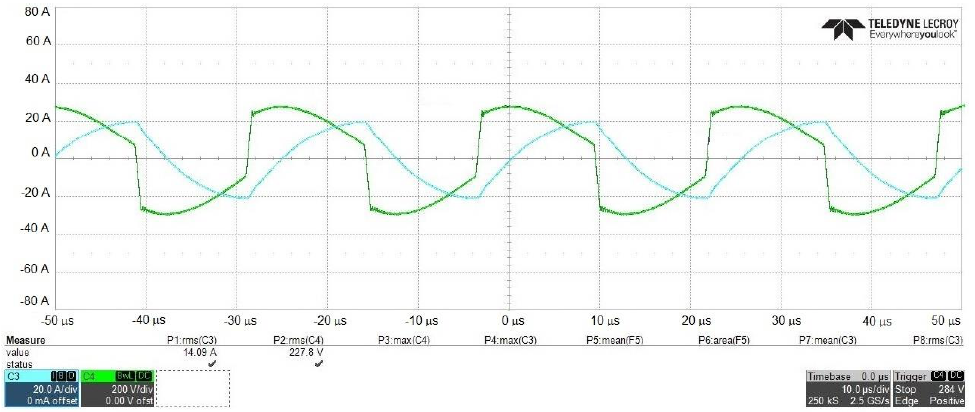
Figure 25. Transmitter coil voltage (C4, green) and current (C3, blue) at 39 kHz.